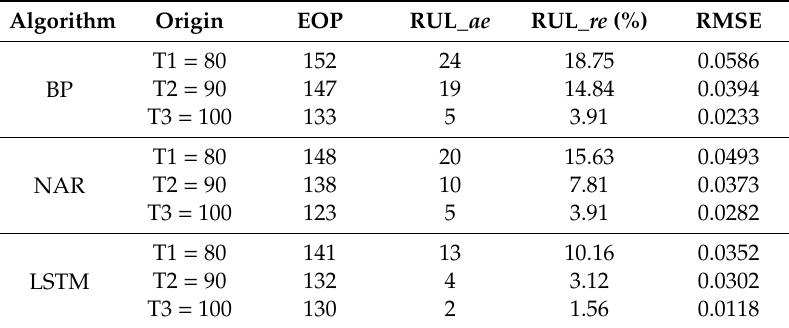
Figure 14. The comparison of three prediction results. Table 1. the comparison of three algorithms of #B5.